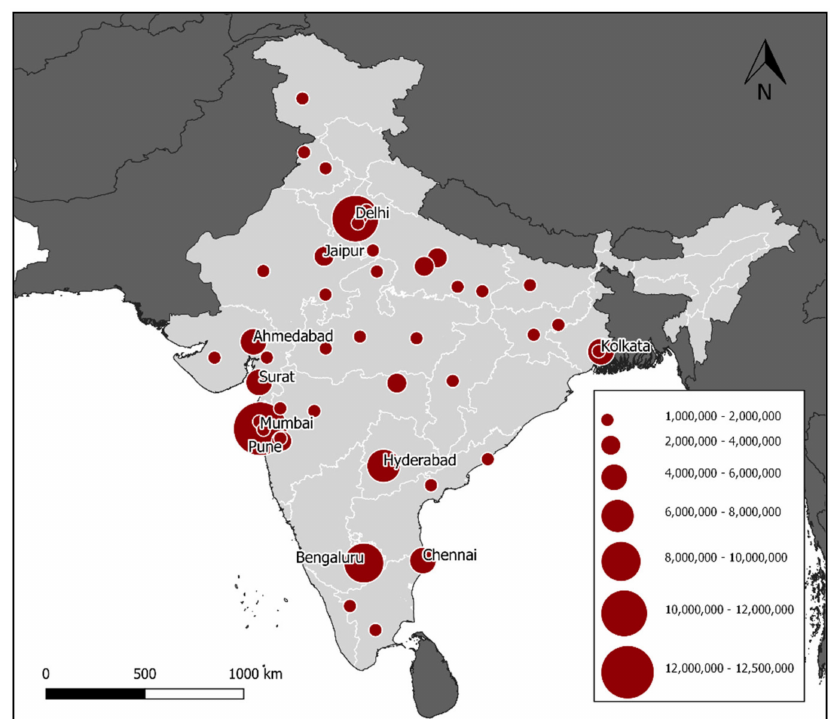
Figure 3. Location of the 46 cities in India with a population of over 1 million people (2011 census), illustrating the need for dog vaccination campaign structures which can be implemented on a massive scale across numerous metropolis settings. The top 10 populous cities are labelled by